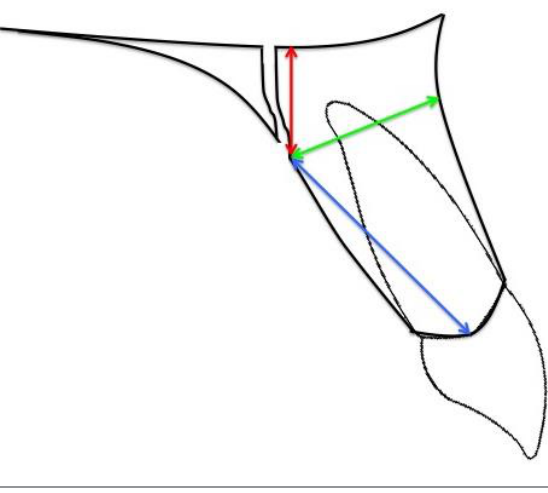
Figure 3. Measurements obtained between the CS and the reference structures in the cross-section of the anterior maxillary region: NC – red arrow, BC – green arrow, and RC – blue arrow.